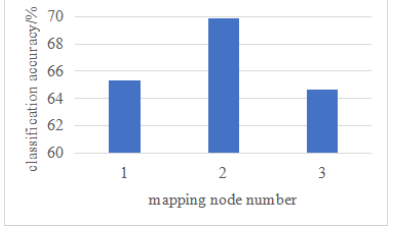
Figure 4. Classification accuracy comparison of different numbers .of LSTM mapping nodes